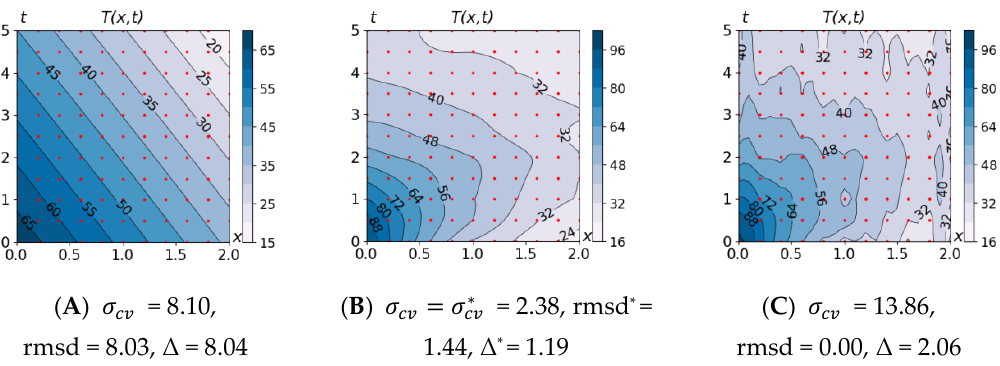
Figure 2. Solutions with different weights of regularization (penalties): ( A ) too big a penalty (undertrained solution); ( B ) optimally balanced SvF solution; ( C ) too small a penalty (overtrained solution).